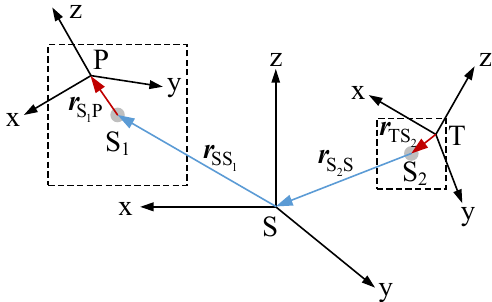
Figure 2. Coordinate systems and positional relationships.